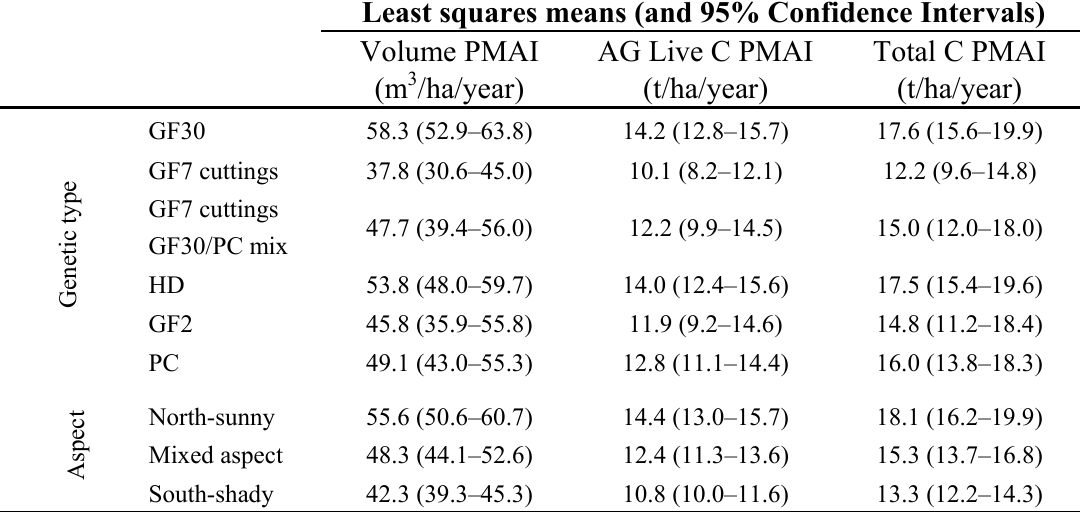
Table 3. Least squares periodic mean annual increment (PMAI) in volume (model R 2 = 90%), above ground live sequestration (model R 2 = 88%), and total carbon sequestration (Model R 2 = 87%) in relation to genetic type and aspect, after allowing for stocking differences at Puruki Forest. PMAI was calculated for 36 plots re-measured at stand ages 9 (2006) and 13 years (2010). Plots had been classified as predominantly North- or South-facing, or alternatively were classified as mixed aspect if the plot included a balance of North and South-facing